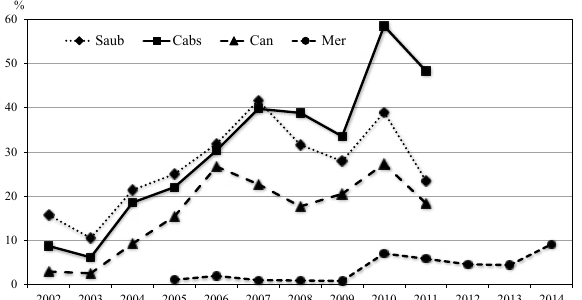
Figure 1. Annual incidence of plants with GLSD foliar symptoms on Sauvignon blanc (Saub), Cabernet sauvignon (Cabs), Cannonau (Can) and Merlot (Mer) in the ten years of